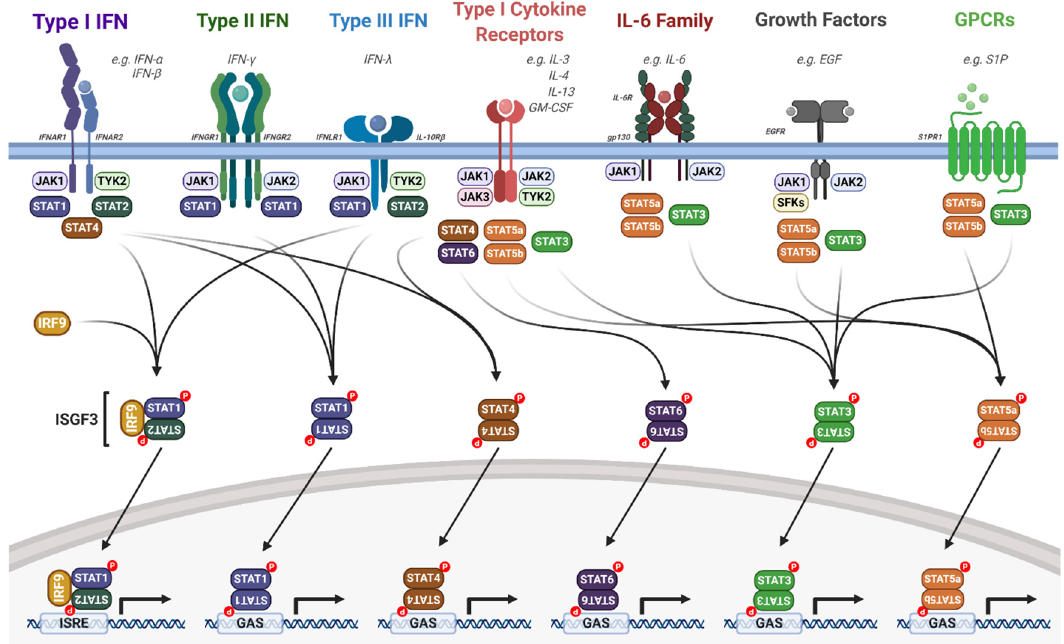
Figure 4. Overview of the JAK/STAT signalling pathway . Upon extracellular ligand binding to their cognate receptors, auto- and/or trans-phosphorylation of JAKs and receptor tyrosine residues occurs, acting as docking sites for STAT proteins. JAK activation leads to the phosphorylation, dimerisation and activation of STAT proteins. Dimerised STATs then translocate into the nucleus and regulate gene transcription by binding to ISRE or GAS elements. Detailed descriptions are outlined in the text. IL, interleukin; IFN, interferon; IFNAR, IFN- α receptor; IFNGR, INF- γ receptor; IFNLR, IFN- λ receptor; EGF, epidermal growth factor; EGFR, EGF receptor; GM-CSF, granulocyte macrophage colony stimulating factor; S1P, sphingosine-1-phosphate; S1PR1, sphingosine-1-phosphate receptor 1; SFKs, Src family kinases; IRF9, interferon regulatory factor 9; ISGF3, interferon stimulated gene factor 3; ISRE, interferon stimulated response element; GAS, gamma interferon activation site. Figure created using